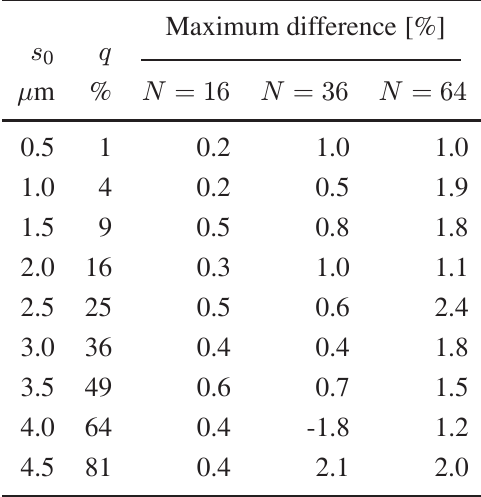
Table 6 . Maximum relative differences in the translational motion damping coef fi cient Z with 3D N-S solver with 250 000 and 450 000